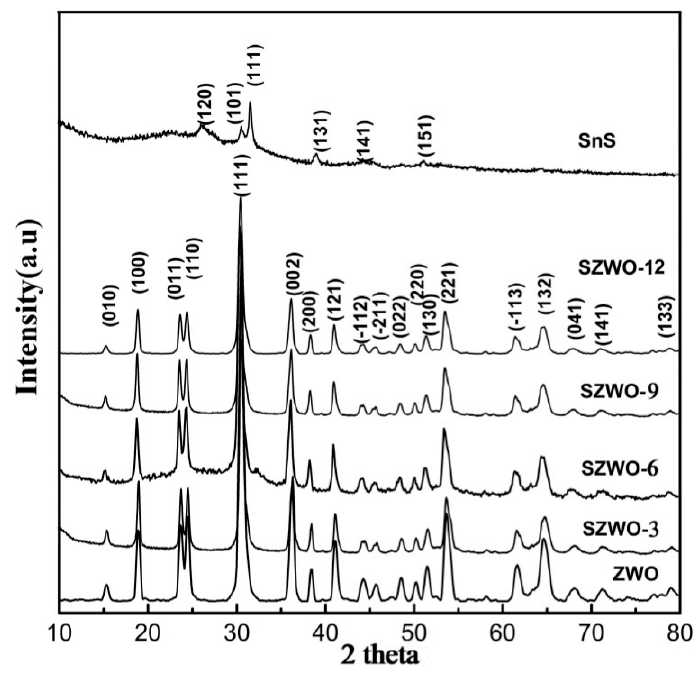
Figure 3. XRD patterns of ZWO, SnS and SnS/ZWO hybrid composites.